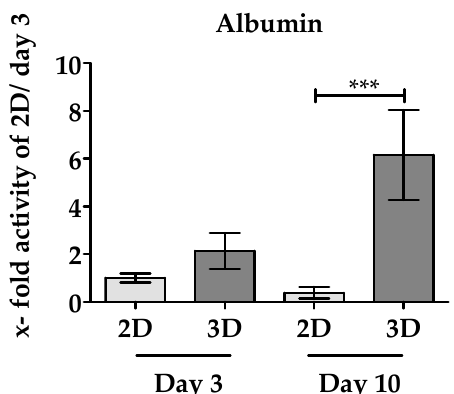
Figure 5. Synthesis of albumin by PHHs in 2D and 3D culture. Supernatants after 24 h incubation time were collected on day 3 and 10 of culture. Albumin production was measured by human Albumin ELISA. Results of 2D cultures are given as bright bars, results of Optimaix-3D cultures are given in dark bars. Data were normalized to the resazurin conversion (viable cells). Data represent an average of N = 4 independent experiments ( n = 3). Bars represent mean ± SEM. *** p ≤ 0.001 as indicated.